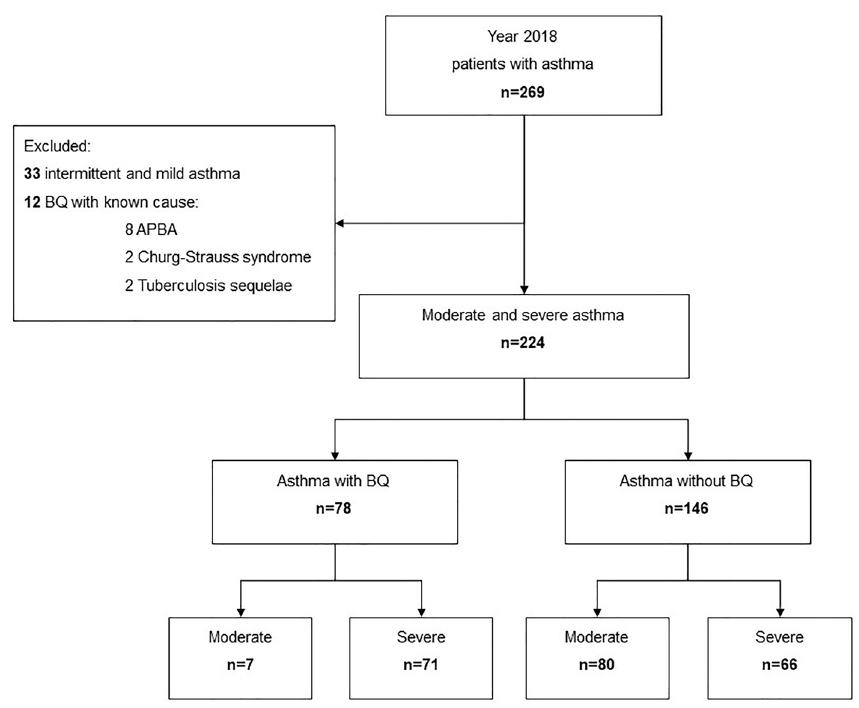
Figure 1. Flow chart of the study population. ABPA: allergic bronchopulmonary aspergillosis; BQ: non-fibrosis